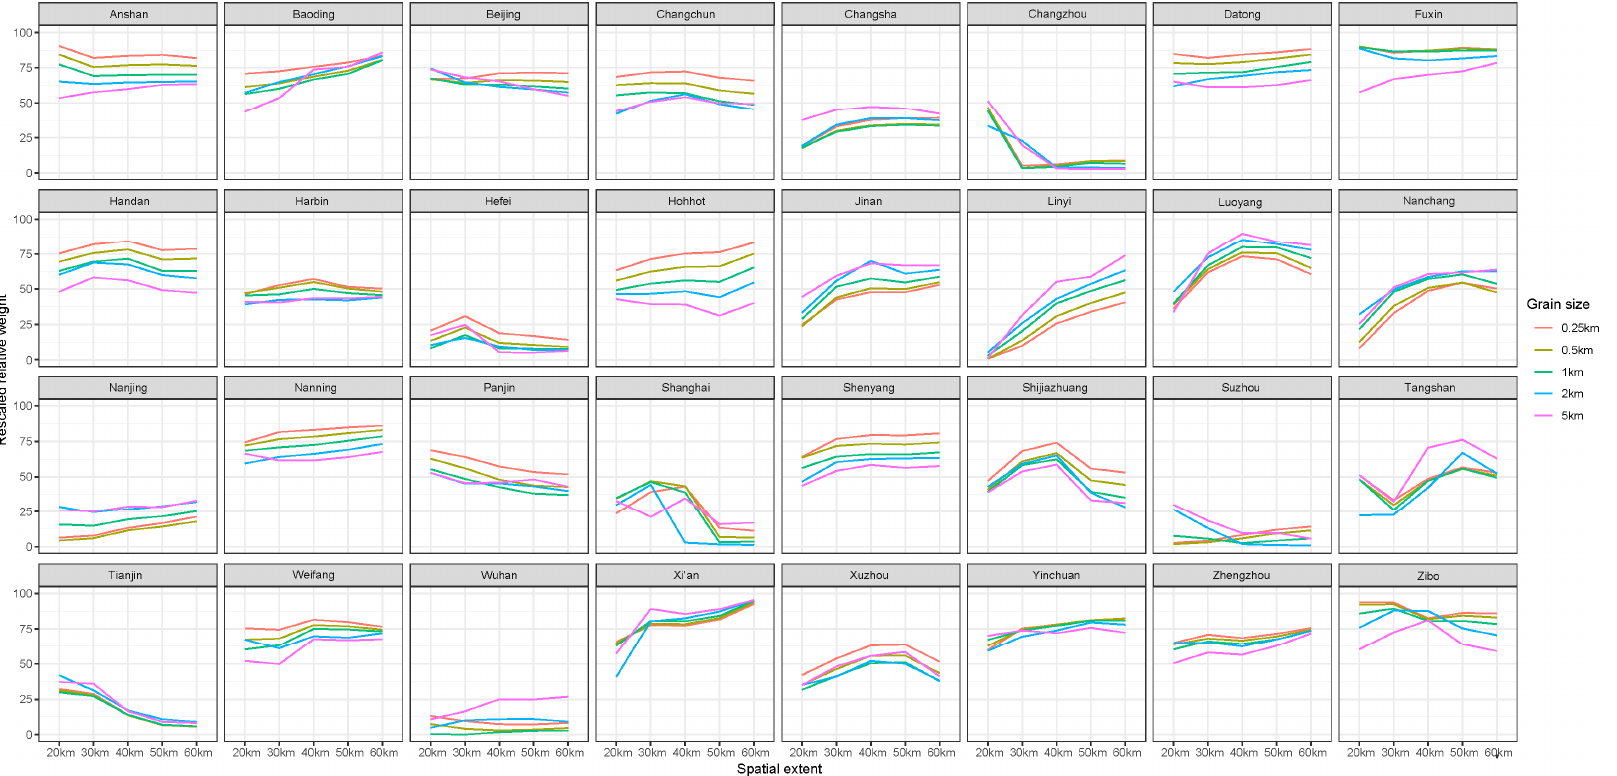
Figure A16. Relative importance of NDVI for explaning LST(Scalogram of the spatial extent).